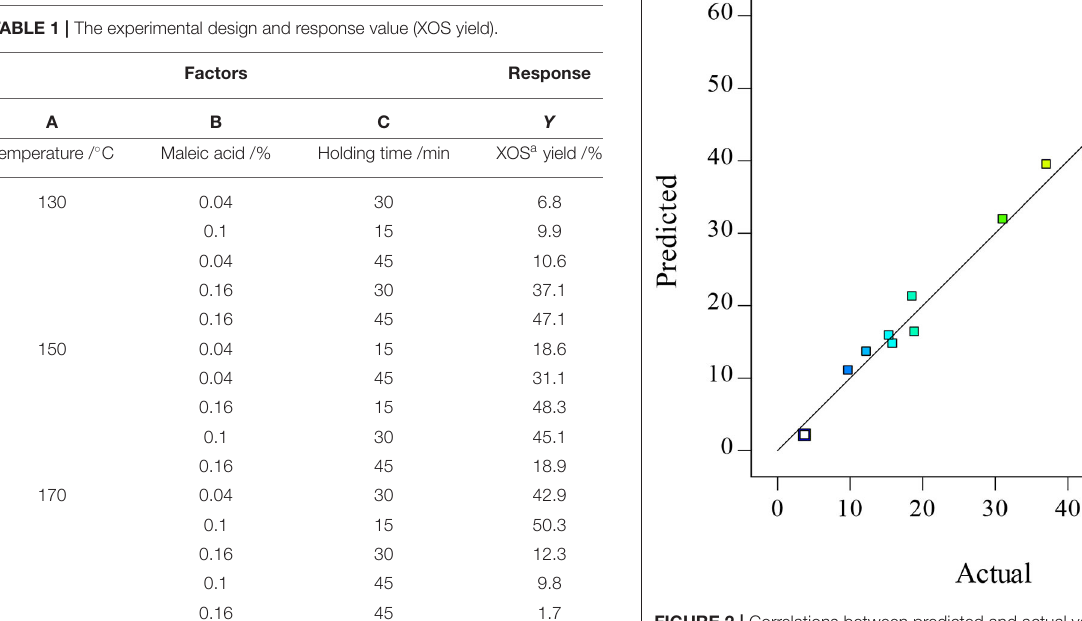
FIGURE 2 | Correlations between predicted and actual values.